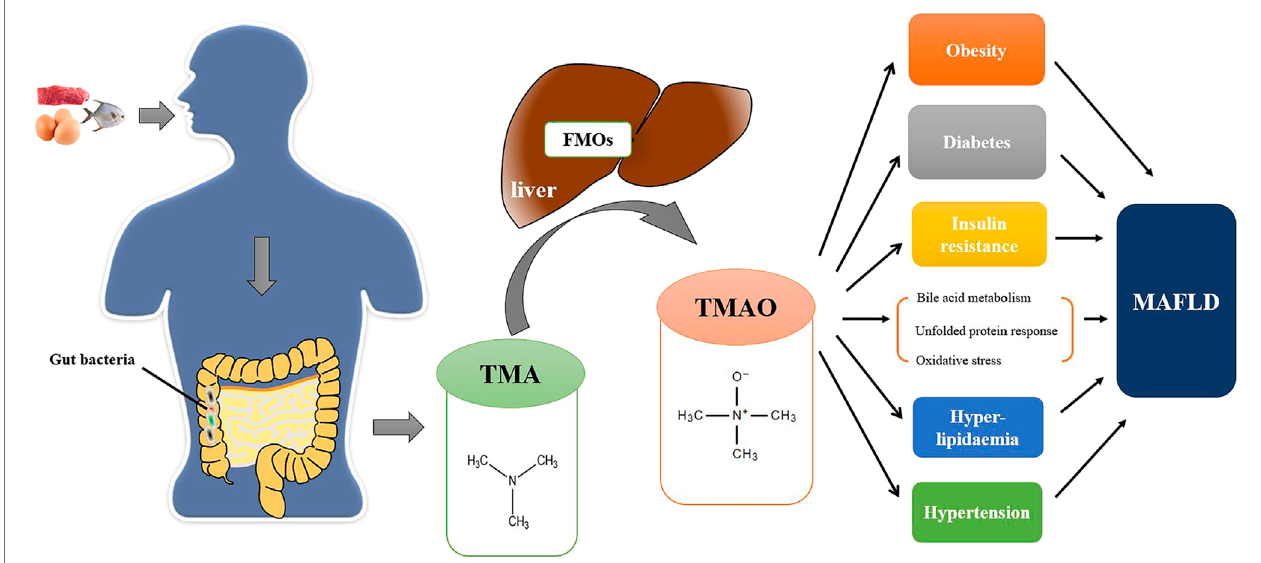
FIGURE 1| The TMAO pathway in the pathogenesis ofMAFLD. Foods (e.g., red meat, eggs, fi sh, etc.) rich in TMA precursors are digested ascholine, L-carnitine, betaine and γ -butyrobetaine in the digestive tract. Excessive TMA precursors that cannot be absorbed are metabolized to TMA by gut bacteria in colon. TMA is then absorbedintothebloodstream throughtheintestinalmucosaandtransformedintoTMAObyFMO1 andFMO3intheliver.TMAOcandirectlypromotethedevelopment of MAFLD by affecting bile acid metabolism, unfolded protein reaction, and oxidative stress and indirectly affect the progression of MAFLD by other metabolic disorders (e.g., obesity, diabetes, insulin resistance,